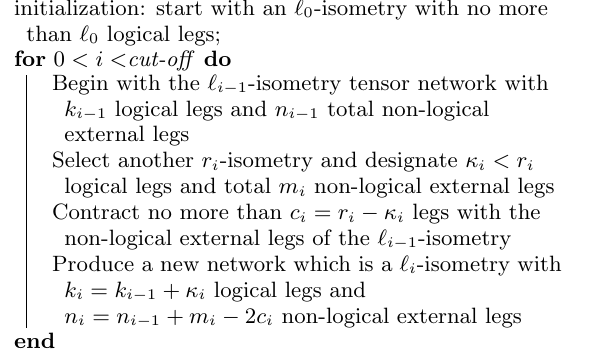
Algorithm 1. Tensor-network building